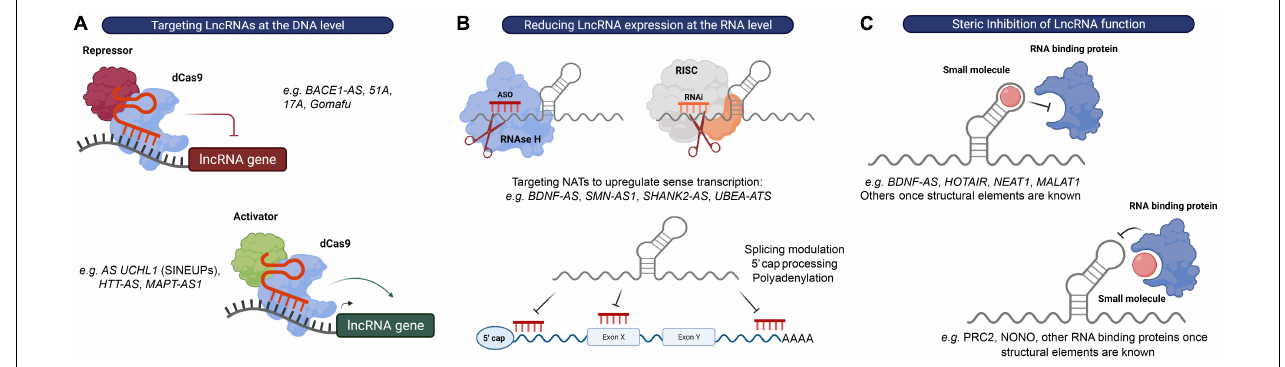
FIGURE 4 | Strategies to target lncRNAs. (A) DNA editing: CRISPRi and CRISPRa tools can be used to transcriptionally silence or activate lncRNA expressing loci, respectively. (B) Modulation of RNA levels: ASOs and siRNAs can be used to reduce lncRNA levels in order to alter the expression of their associated protein-coding genes. recruits RBPs that mediate RNA processing events, such as 5 (cid:48) capping, splicing or polyadenylation, to modulate expression or RNAse H to promote degradation of the lncRNA transcript, respectively, while RNAi induces RISC-mediated cleavage of the lncRNA transcript. (C) Steric inhibition: small molecules target secondary and tertiary structures of lncRNAs and/or their binding partners to block their